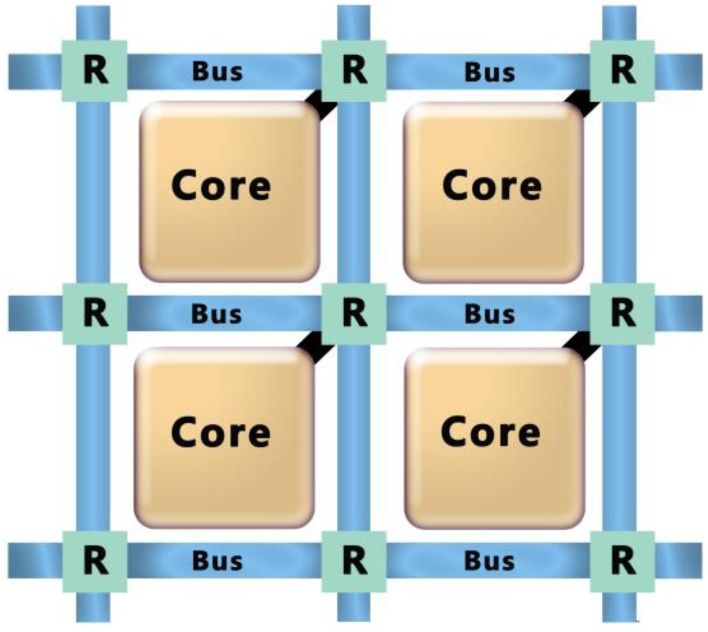
A system would consist of individual crossbar based cores that communicate with each other through a communications bus and routing system.